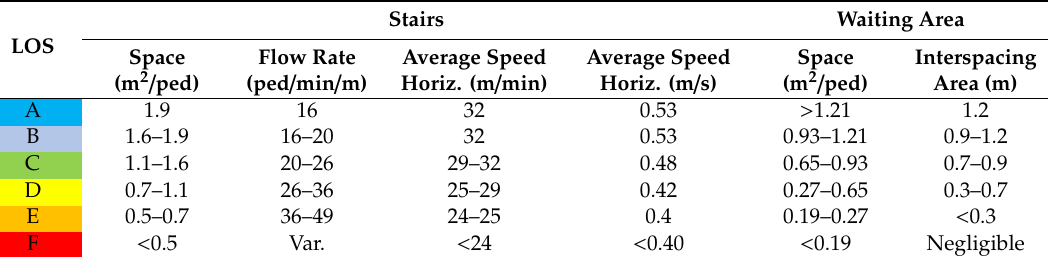
Table 4. LOS values considering stairs and waiting